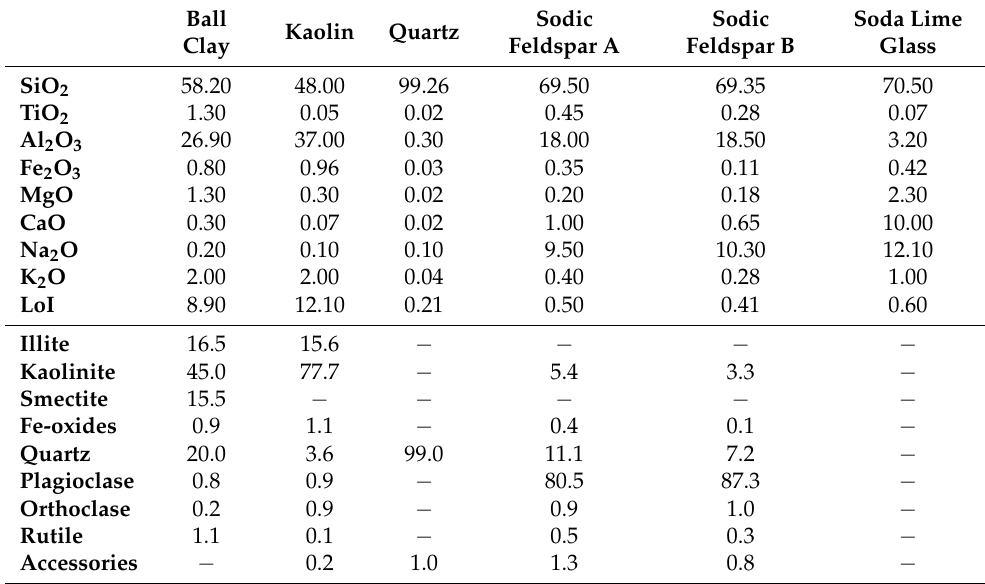
Table 1. Chemical and mineralogical composition of raw materials.